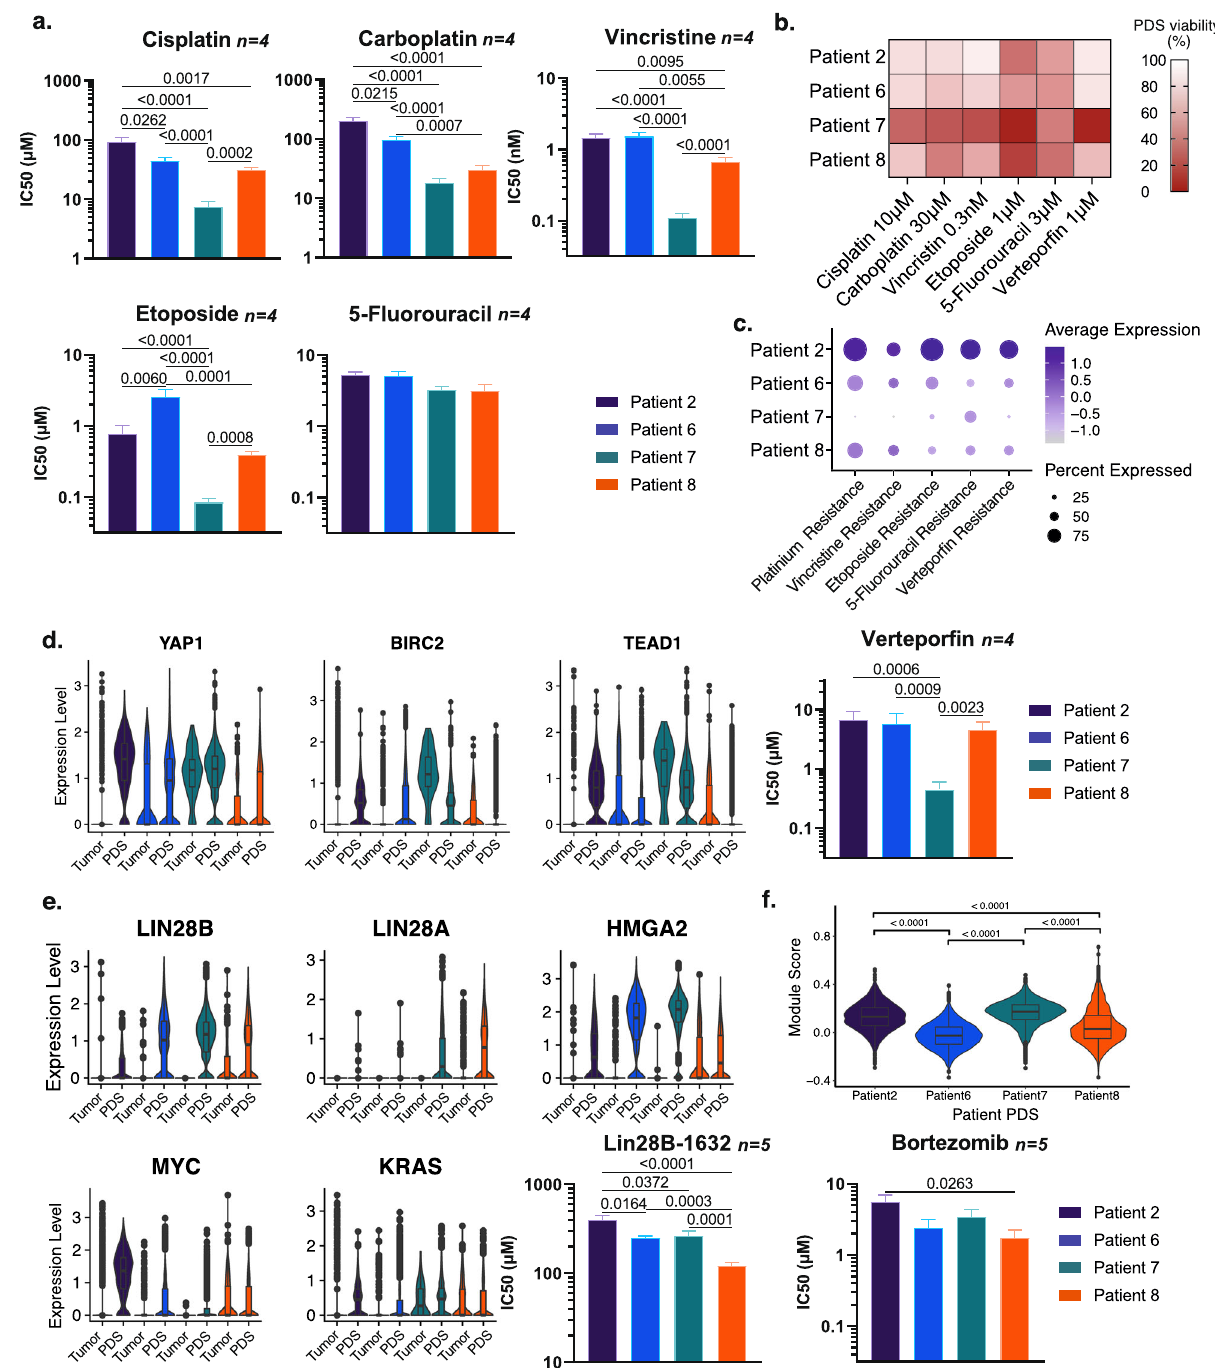
Fig.6 | Pharmacologic testingofpatient-derivedHBspheroidsrevealspatient- speci fi c treatment responses. a IC50 calculated from cell viability measurements by ATP quanti fi cation after a 4-day treatment with fi ve chemotherapy drugs (cis- platin, carboplatin, etoposide, vincristine and 5- fl uorouracil [5-FU]). b PDS drug- sensitivity heatmap showing cell viability pro fi le for the fi ve chemotherapy drugs tested and vertepor fi natarepresentative concentration. c Module scorefor genes involved in platinum-based compounds, etoposide, vincristine, 5-FU, and verte- por fi nmetabolismandef fl ux. d ViolinplotsshowingtheexpressionofYAP1,BIRC2 and TEAD1 in parent cells and PDS, and IC50 calculated from cell viability mea- surements of ATP quanti fi cation after a 4-day treatment with the YAP1 inhibitor vertepor fi n. e Violin plots showing the expression of LIN28B, LIN28A, HMGA2, MYC, and KRAS in parent cells and PDS, and IC50 calculated from cell viability measurementbyATPquanti fi cationaftera4-daytreatmentwiththeLIN28pathway inhibitor LIN28B-1632. f Violin plot showing the module score of proteasome